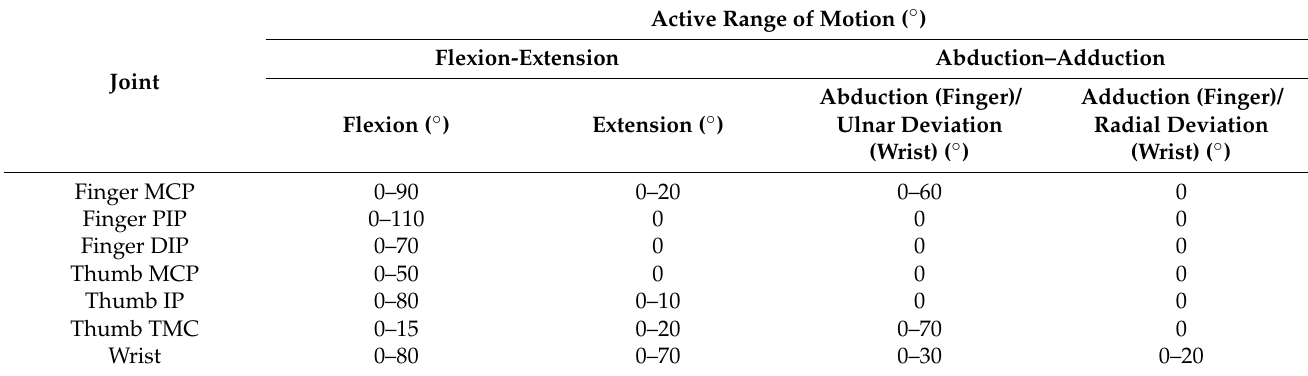
Table 1. The active range of motion of the wrist and joints of